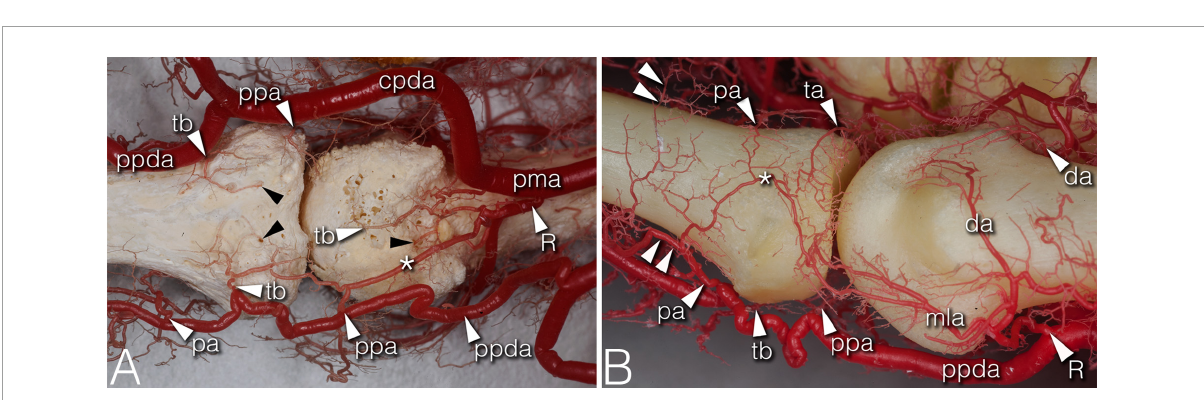
FIGURE3 Arteries of the phalangeal territory on corrosion cast specimens. (A) (4th finger, palmar view) Note the long anastomosis between the R-branch and the palmar plate artery. Proximal from the anastomosis a short trunk arises acting as a tenosynovial vessel, with one branch reaching to the metacarpal head and another branch extending to the projection of the flexor tendon. (B) (2nd finger, dorsolateral view) The phalangeal arcade originates as one common trunk, with one branch supplying the arcade on the dorsal surface of the phalanx, and another branch forming a more superficial arcade according to the projection of the extensor hood. The triangular and phalangeal arcade are in connection through a short anastomosis. Note the small branches from the triangular arcade showing a pectinate character in the axial plane. *, anastomosis; cpda, common palmar digital artery; da, dorsal arcade; mla, main lateral artery; pa, phalangeal arcade; pma, palmar metacarpal artery; ppa, palmar plate artery; ppda, proper palmar digital artery; R, R-branch; ta, triangular arcade; tb, tenosynovial branch; black arrowheads, entry point of enosseal arteries; doubled arrowheads, supplying arch for the extensor